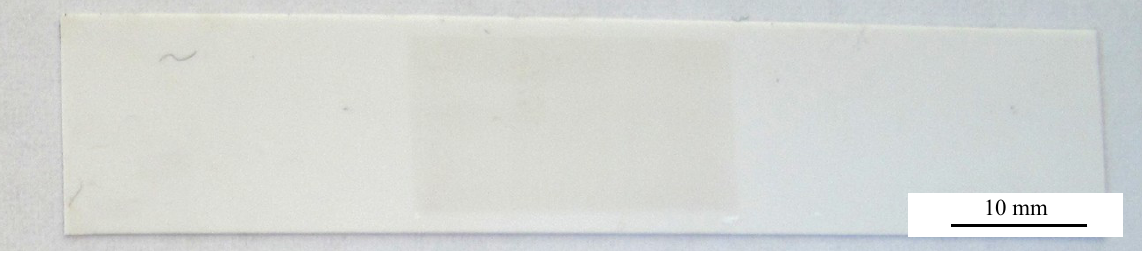
Figure 6. Example for a typical Al Deposition parameters: 100% O